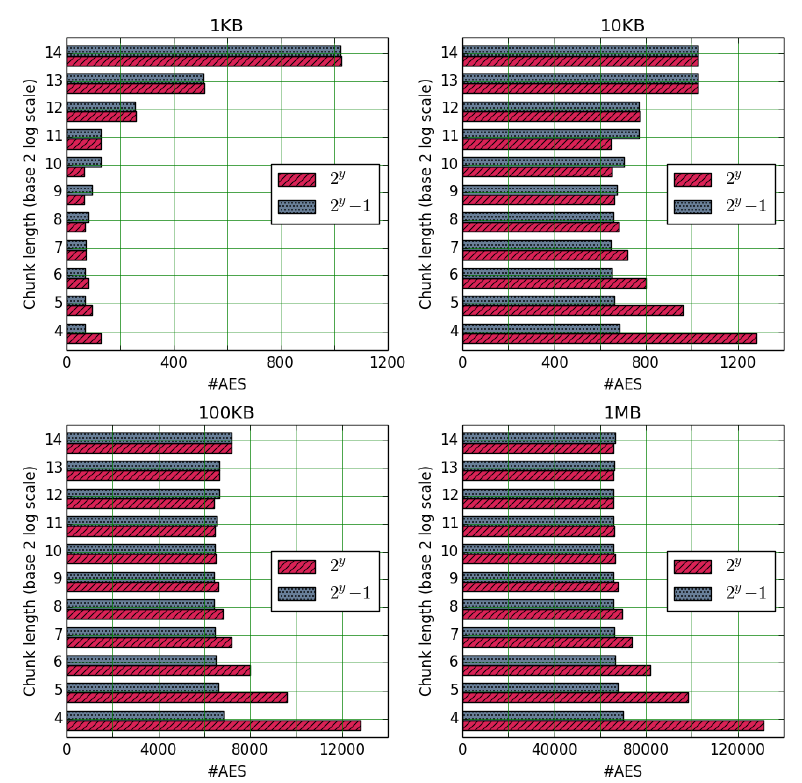
Figure 12: Number of AES operations needed to IM -encrypt a message as a function of the chunk length, with the choice of AES - GCM as internal nonce-based AE scheme. Plots are given for 4 different message lengths: 1KB, 10KB, 100KB and